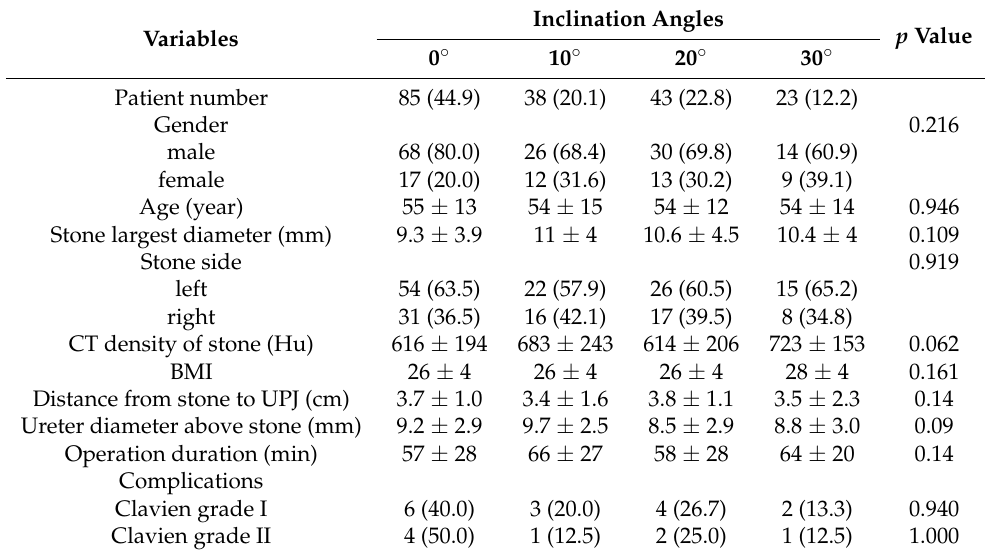
Table 1. Summary of clinical characteristics and comparisons between groups with different inclination angles.